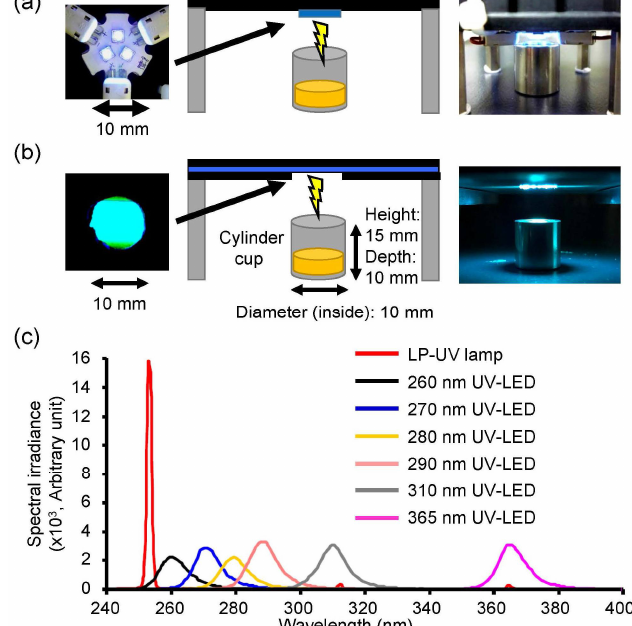
Figure 1. Irradiation system setup and emission spectrum of the UV-LEDs and low pressure-mercury (LP)-UV lamp used in this study. Photographs and schematic images of the UV-LEDs ( a ) and LP-UV lamp ( b ). ( c ) Emission spectrum of UV-LEDs. Detailed conditions of UV-LED irradiations are listed